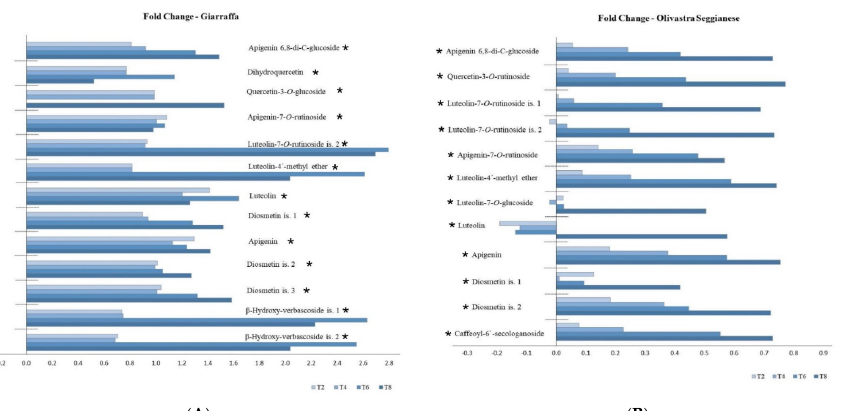
Figure 1. Fold changes (log 2 (UV-B/control)) in phenolic metabolites of the Giarraffa ( A ) and Olivastra Seggianese ( B ) varieties after UV-B treatment sampled at the 2nd (T2), 4th (T4), 6th (T6), and 8th (T8) week after the onset of stress. ANOVA showed that most of chemical components were significantly affected by the main factors and their interactions. An asterisk (*) indicates a significant interaction between treatment vs. variety and treatment vs. sampling time. Concerning the factors of treatment and sampling time, an interaction of these two factors was observed for all lipophilic compounds identified (Table S2). For the cases of neophytadiene, lupeol derivative, oleic acid derivative, and stigmast-5-en (only present in Giarraffa), the UV-B plants at T6 showed the highest levels, and for the other remaining compounds, they were more abundant in the UV-B plants at T8. Figure 2 shows the rate of change in lipophilic metabolites of Giarraffa (A) and Olivastra Seggianese (B) after UV-B treatment at different sampling times (T2, T4, T6, and T8). In the Olivastra Seggianese variety (Figure 2B), the response profiles of some lipophilic metabolites progressively increased as stress progressed: phytol, ursolic acid, α -D-mannopyranose, D-sorbitol, α -D-thalopyranose, α -linolenic acid, and long-chain alkane 4. Other metabolites, however, did not show a progressive increase, but had peaks at T4 or T6 or both time points, as in the cases of neophytadiene; β -amyrin; lupeol derivative; long-chain alkanes 1, 2, and 3; and stigmast-5-ene. Others, such as palmitic and oleic acids, had peaks at T4 and T8. In addition, the stearic acid response intensity decreased progressively from T2 to T6 and then increased again slightly at T8, whereas the long-chain alkane 5 response intensity decreased with progressing stress from T2 to T8. In the Giarraffa variety (Figure 2A), the response profiles of some lipophilic metabolites increased progressively with stress: α -D-mannopyranose, α -D- thalopyranose, and D-sorbitol. Other metabolites, however, did not show a progressive increase, but had peaks at T4 and T8, such as phytol; β -amyrin; ursolic, palmitic, β - linolenic, and stearic acids; and long-chain alkanes 1, 2, 3, 4, and 5. For some lipophilic metabolites, such as f lupeol derivative and oleic acid derivative, a steady decrease, albeit with fluctuations, was observed in stressed samples compared to controls.